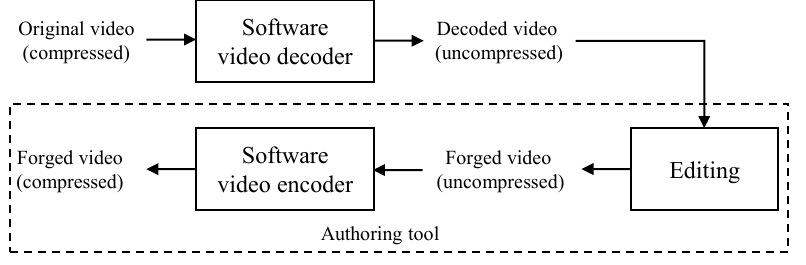
Figure 1. Procedure of video forgery by double